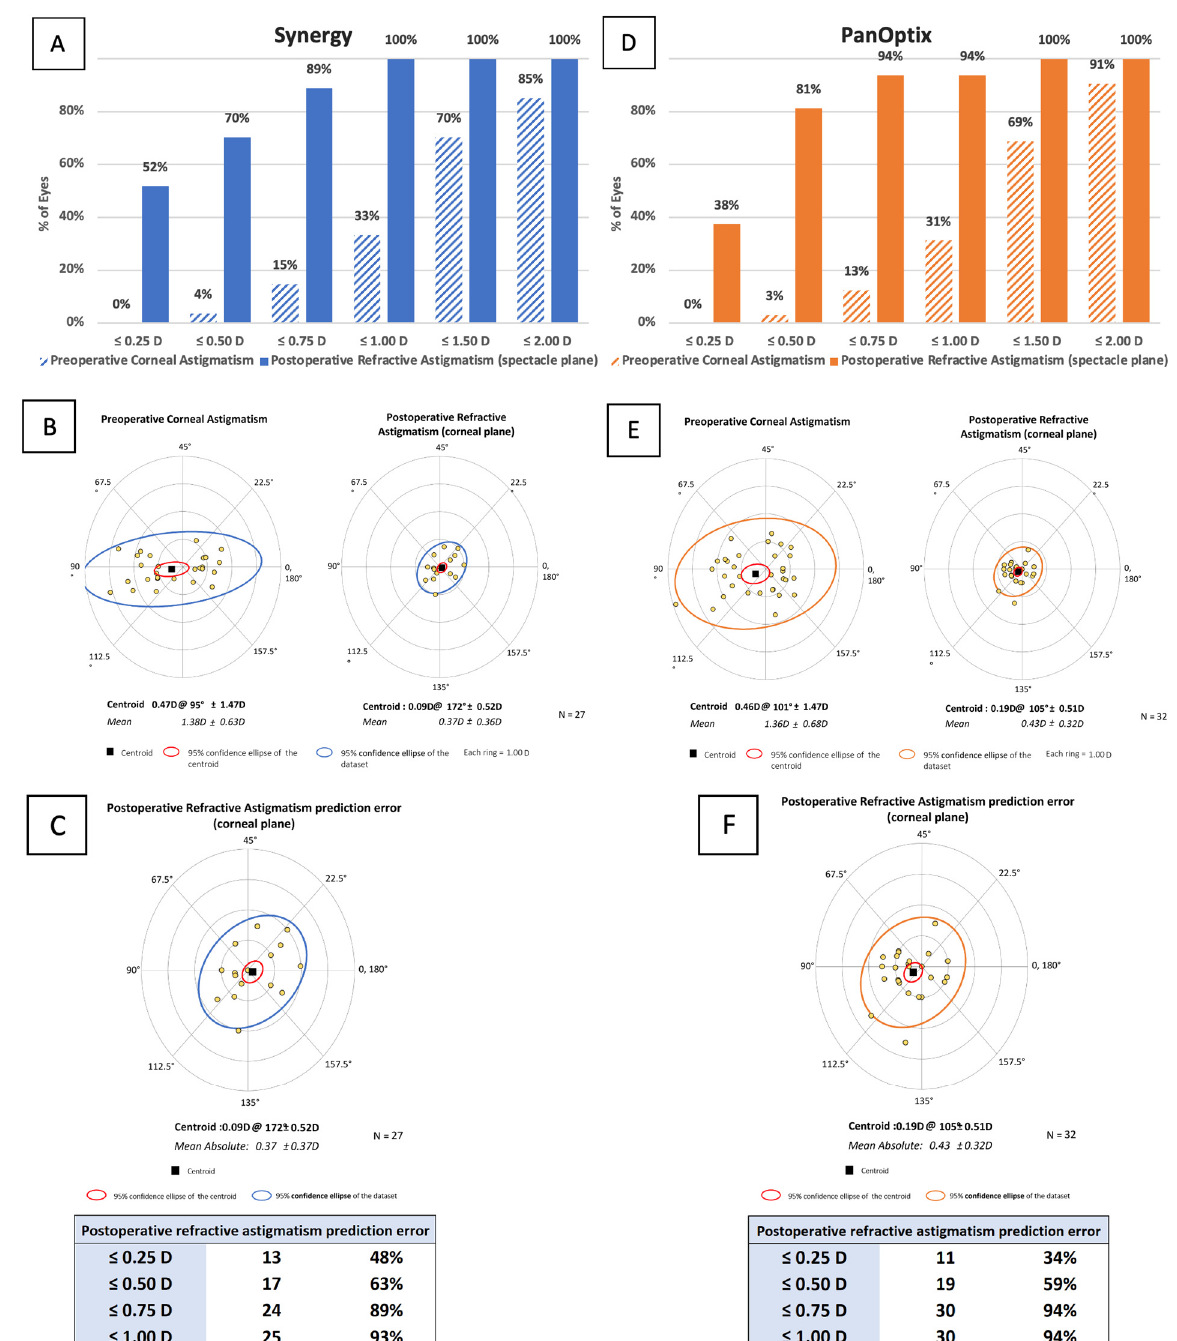
Figure 3. Vector analysis for the TECNIS Synergy group and the AcrySof IQ PanOptix group: ( A , D ) Preoperative corneal astigmatism and postoperative refractive astigmatism cumulative histogram measuring magnitude; ( B , E ) Preoperative corneal astigmatism and postoperative refractive astigmatism double-angle plots showing the centroid and standard deviation; ( C , F ) Refractive astigmatism prediction error double-angle plot, postoperative refractive astigmatism prediction error values.